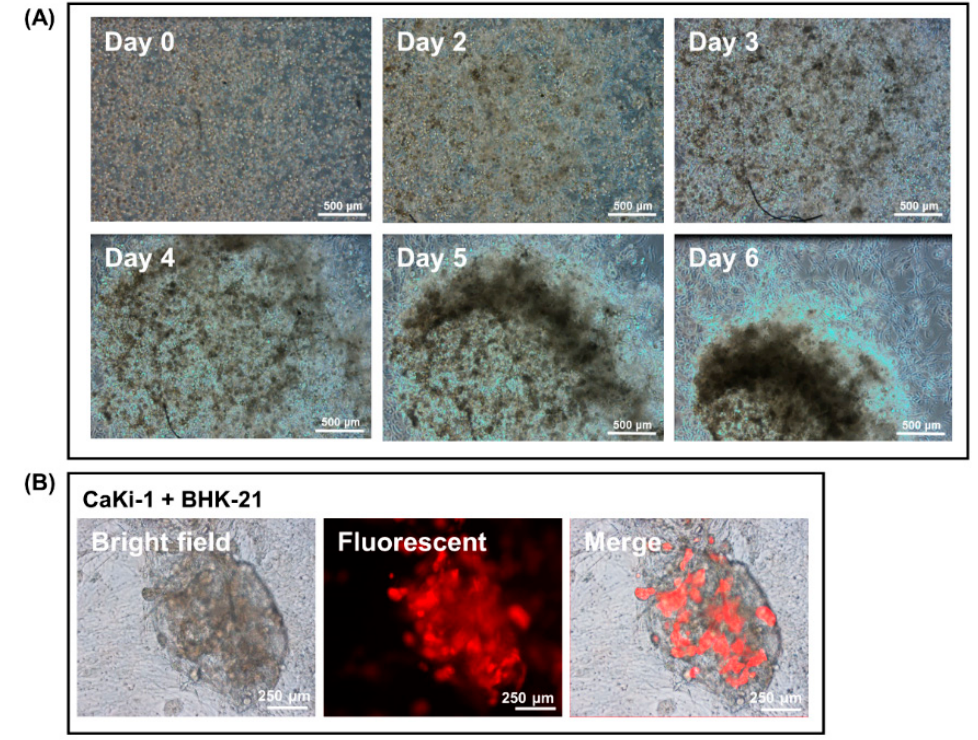
Figure 3. Encapsulation of cancer cells by fibroblast spheroids in a 3D Matrigel droplet. ( A ) Snapshot images from a video that show the process of CaKi-1 cell encapsulation by a fibroblast spheroid on days 0, 2, 3, 4, 5 and 6 (video in Supplement 1). ( B ) RFP-labelled CaKi-1 cancer cells trapped inside a fibroblast spheroid from a separate experiment as viewed under brightfield and fluorescent microscopy.